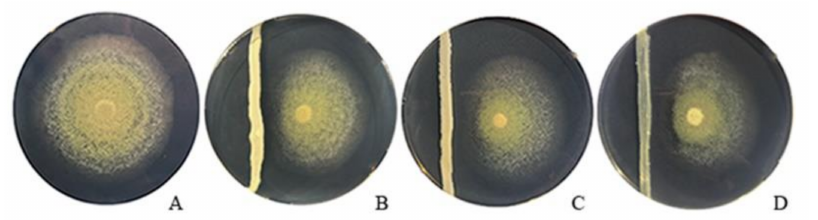
Figure 2. In vitro inhibitory activity of three isolated yeasts against P. digitatum on PDA medium after 10 days’ incubation at 25 ◦ C. ( A ) Control plate inoculated only with the pathogen. ( B – D ) Plates inoculated with the pathogen and a strip of yeasts: AgL2, AgL21, and AcL2,